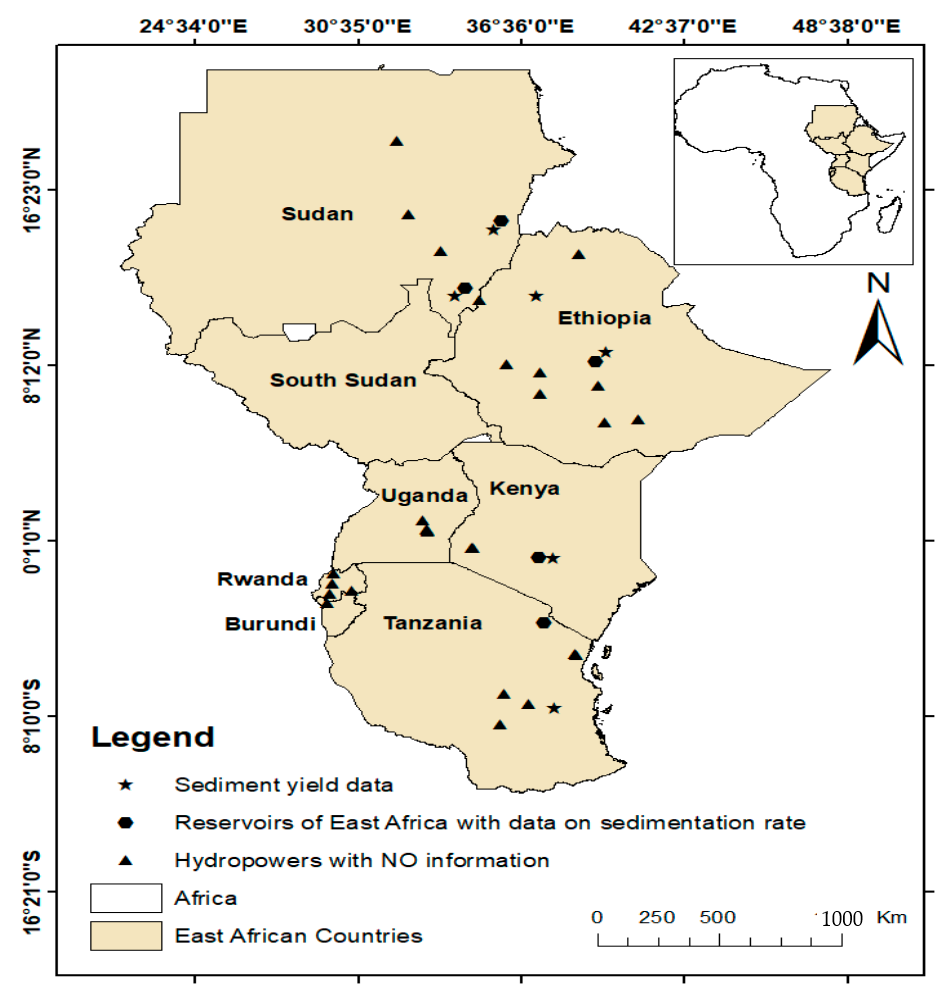
Figure 2. Selected hydropower dams in the Eastern Africa region; hexagons indicate dams with available data on sedimentation rates, stars indicate dams with available data on sediment yields, and triangles indicate dams with no available information on sedimentation rate or sediment yield.